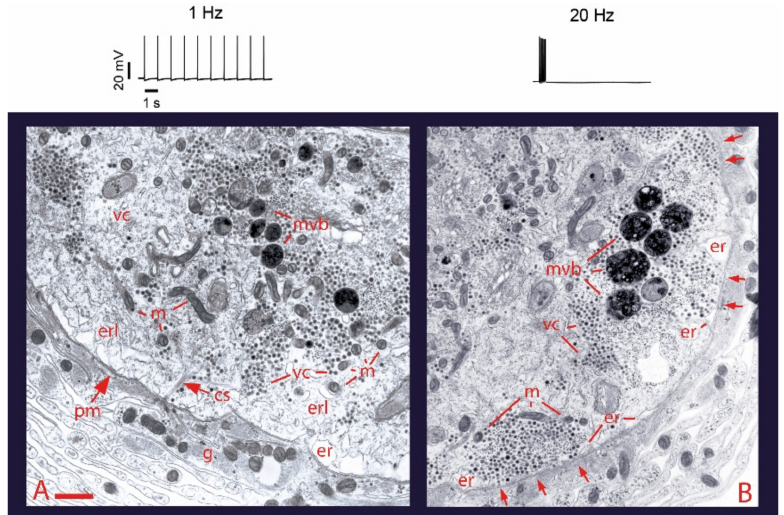
Figure 1. Electrical activity promotes vesicle transport to the plasma membrane. ( A ) Electron micrograph of a soma fixed after 1 Hz stimulation (train on top). Vesicle clusters remain dis- tant from the plasma membrane. ( B ) After 20 Hz stimulation (top) vesicle clusters appear ap- posed to the plasma membrane (arrows). vc = vesicle clusters; mt = microtubules; pm = plasma membrane; m = mitochondria; er = endoplasmic reticulum; erl = internal endoplasmic reticulum layers; mvb = multivesicular bodies; g = glial cell processes. Scale bar = 1 µ m. Obtained with permission from